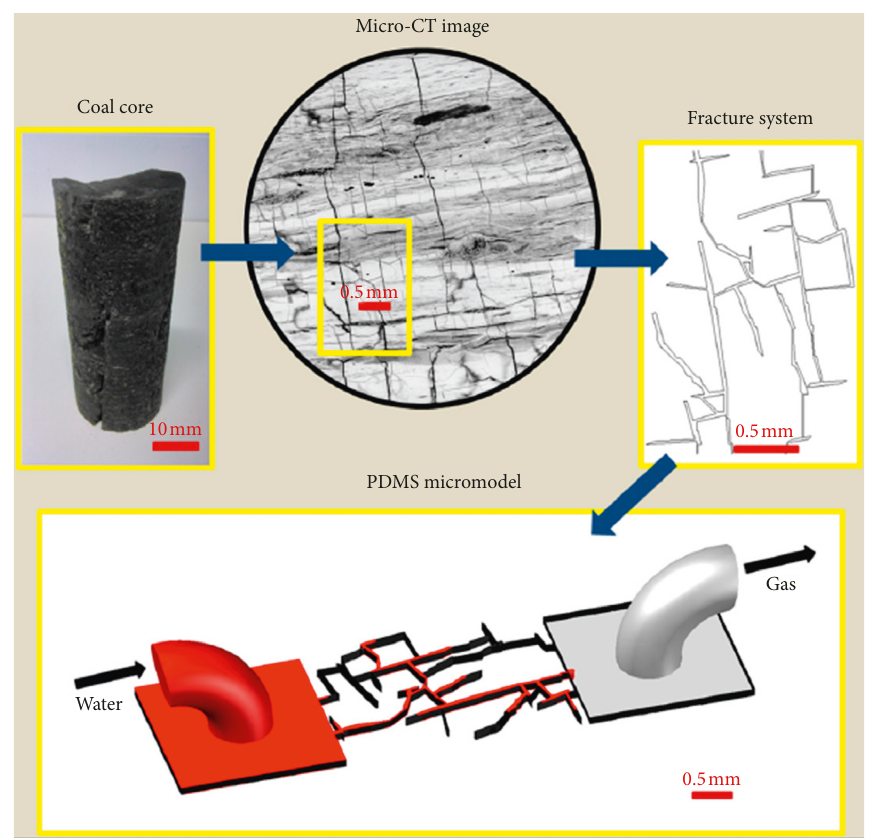
Figure 12: Reservoir-on-chip model used to depict the fracture structure in a coal reservoir [247].